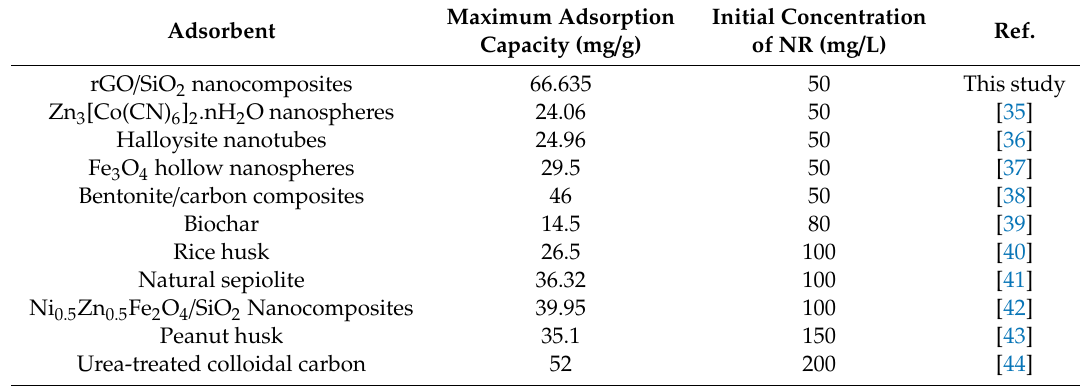
Table 3. Maximum adsorption amounts of various adsorbents toward the removal of NR dye from the aqueous solution at room